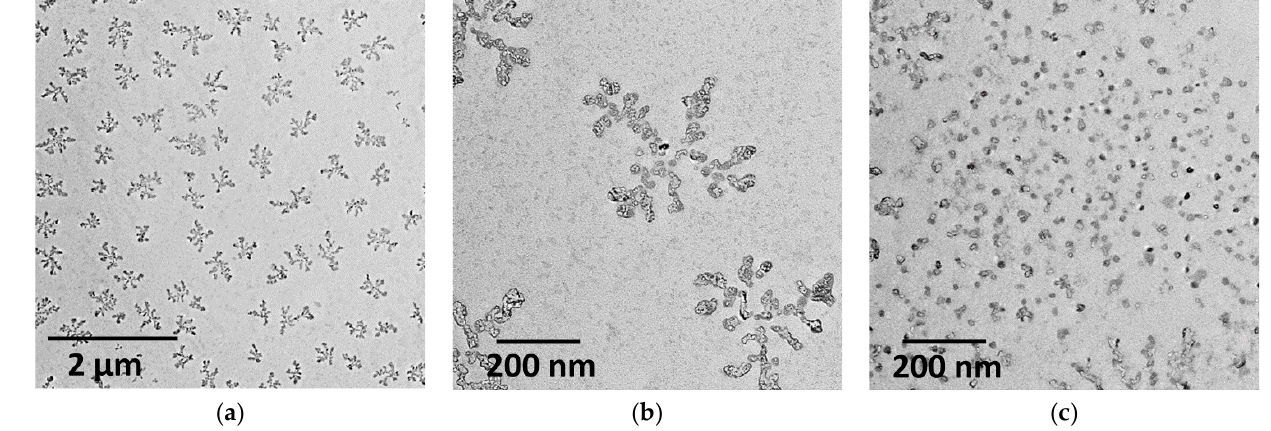
Figure 3. TEM- photos of empty F1 chitosomes at different scales: 2 µM ( a ); 200 nm ( b , c ).